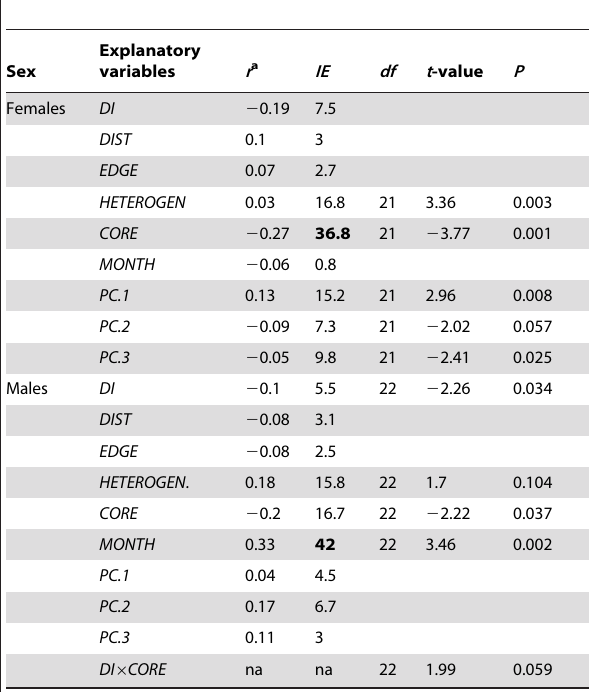
Table 8. Relationships between haemoglobin-haemtocrit residuals (HHR) (g ? L 2 1 ) and environmental variables for agile